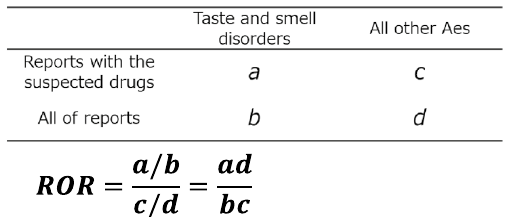
Figure 5. Cross-tabulation and calculation formula of for the reporting odds ratio (ROR) of taste and smell disorders. ( a ) Number of cases of taste and smell disorders attributable to the suspected drug. ( b ) Number of cases of taste and smell disorders attributable to other drugs. ( c ) Number of cases of other AEs attributable to the suspected drug. ( d ) Number of cases of other AEs attributable to other drugs. ROR was calculated using the presented formula.